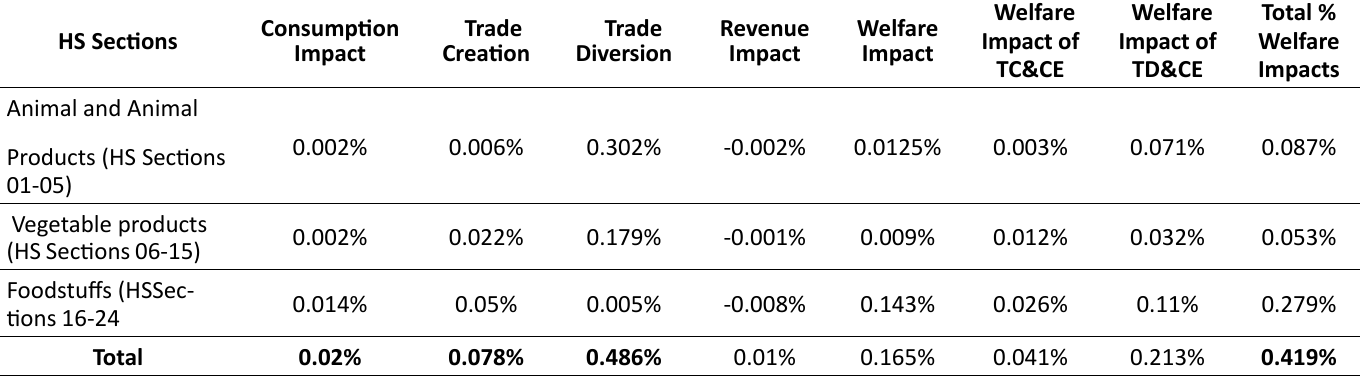
Table 2: Impacts of the Product Sections as % Contribution of Agriculture to National